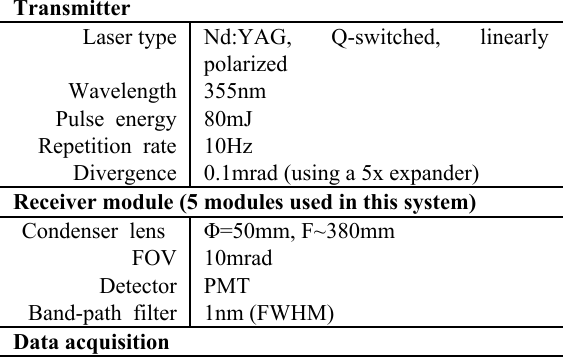
Fig.1 The MFMSPL system developed in this study. (a) Configuration of the entire system. (b) Configuration of the receiver module. Table 1. Specifications of the MFMSPL